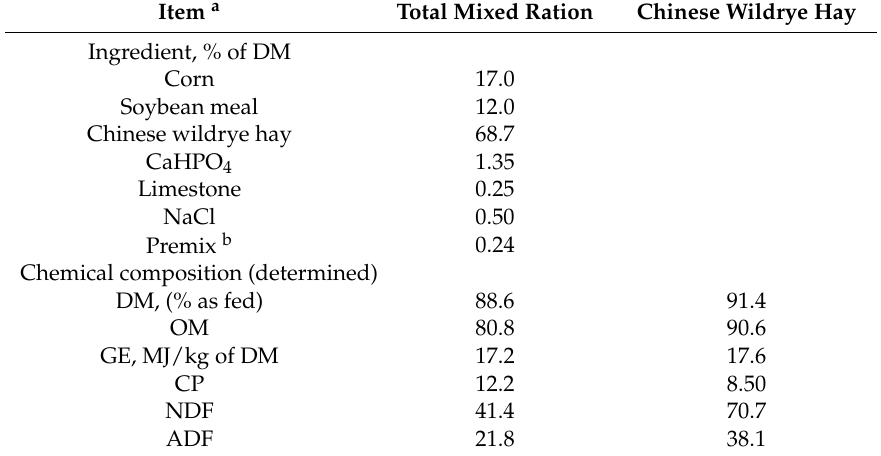
Table 1. Ingredients and chemical compositions of experimental diets (% of dry matter (DM)). Item a Total Mixed Ration Chinese Wildrye Hay Ingredient, % of DM Corn 17.0 Soybean meal